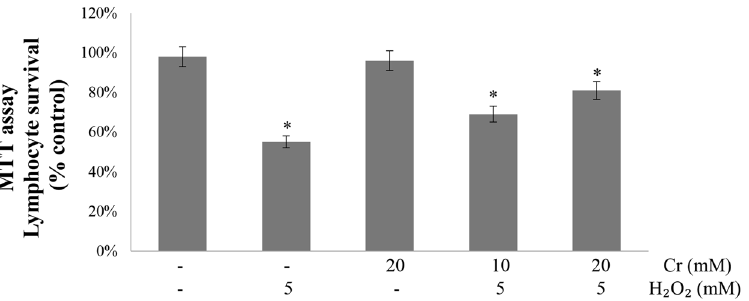
Fig 8. Effect of creatine on H 2 O 2 -induced decrease in lymphocyte viability. Human lymphocytes were treated with H 2 O 2 in presence and absence of Cr and then their viability was determined by the MTT assay. Results are mean values ± SEM from five independent experiments using blood from different donors. * Significantly different from control (p <